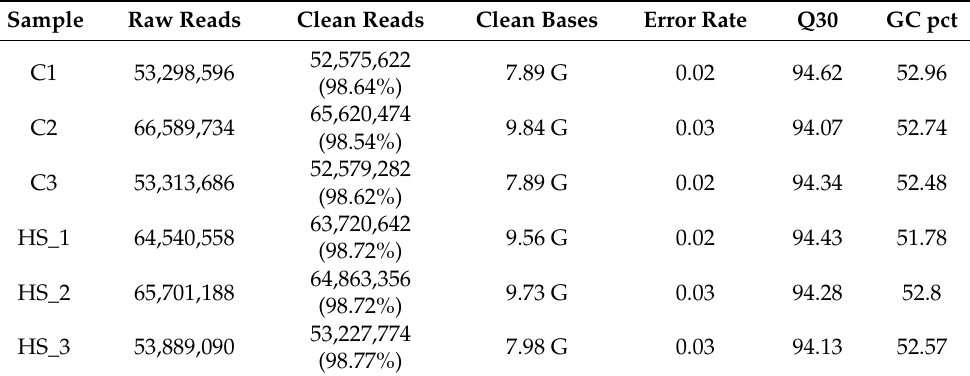
Table 1. Summary of the RNA-seq results of porcine uterine RNA samples.